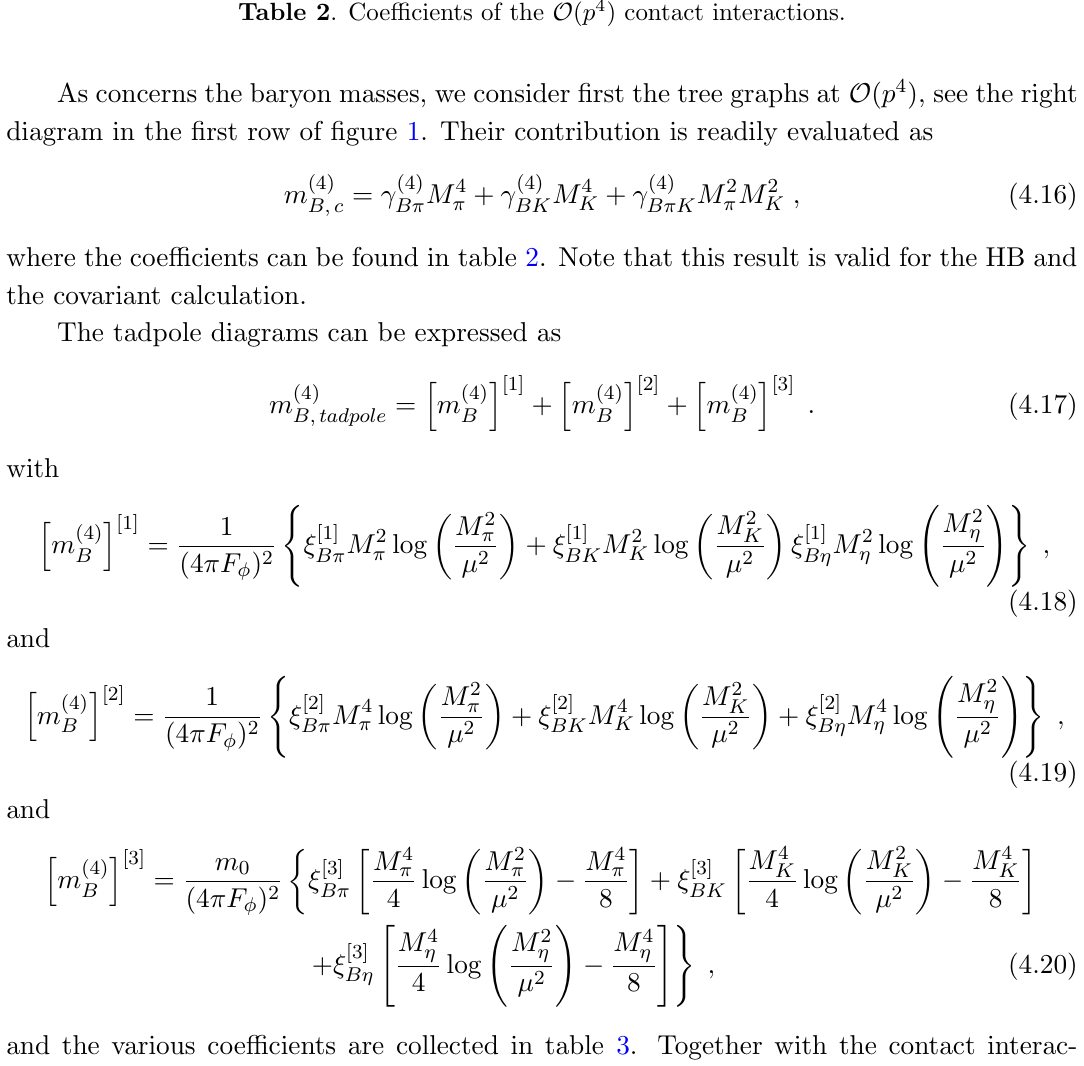
Table 2 . Coe(cid:14)cients of the O ( p 4 ) contact